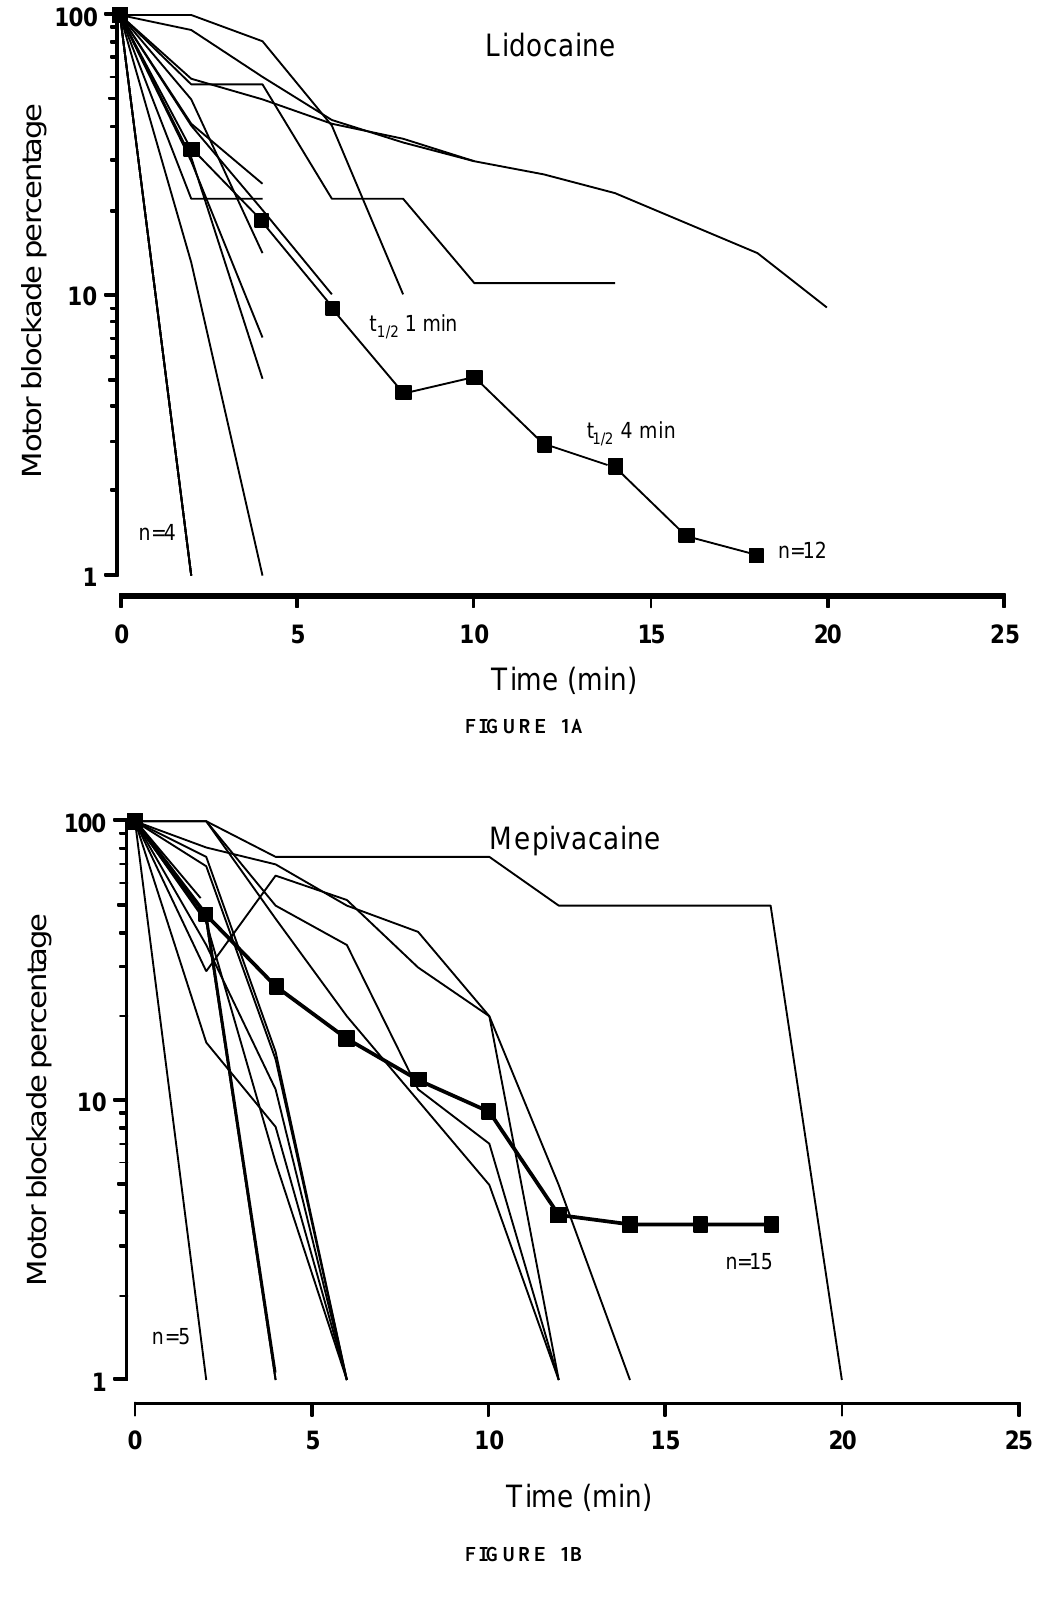
FIGURE 1 . (A) Individual and mean (n = 12) percentage motorblockade–time curves of lidocaine, after axillary administration of 600 mg lidocaine (+ 5 m g ml –1 adrenaline). Three patients failed to develop a motor block. (B) Individual and mean (n = 15) percentage motorblockade–time curves of mepivacaine, after axillary administration of 600 mg mepivacaine (+ 5 m g ml –1